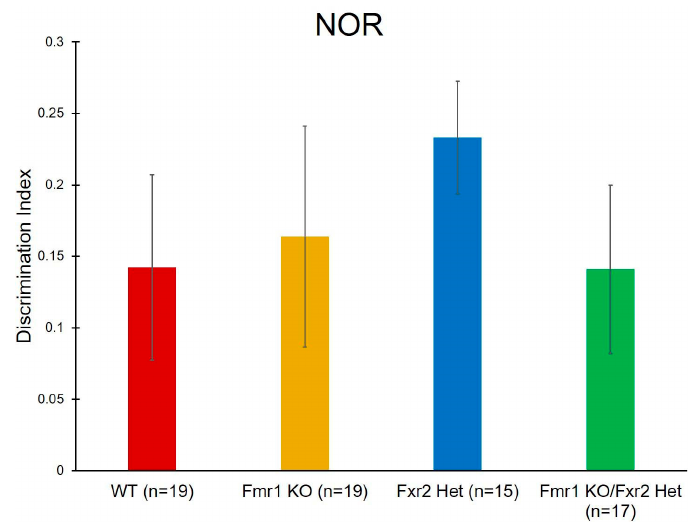
Figure 6. To assay learning and memory, we performed novel object recognition (NOR). We did not find any statistically significant effects. Bars represent the means ± SEMs for the number of mice indicated in parentheses.